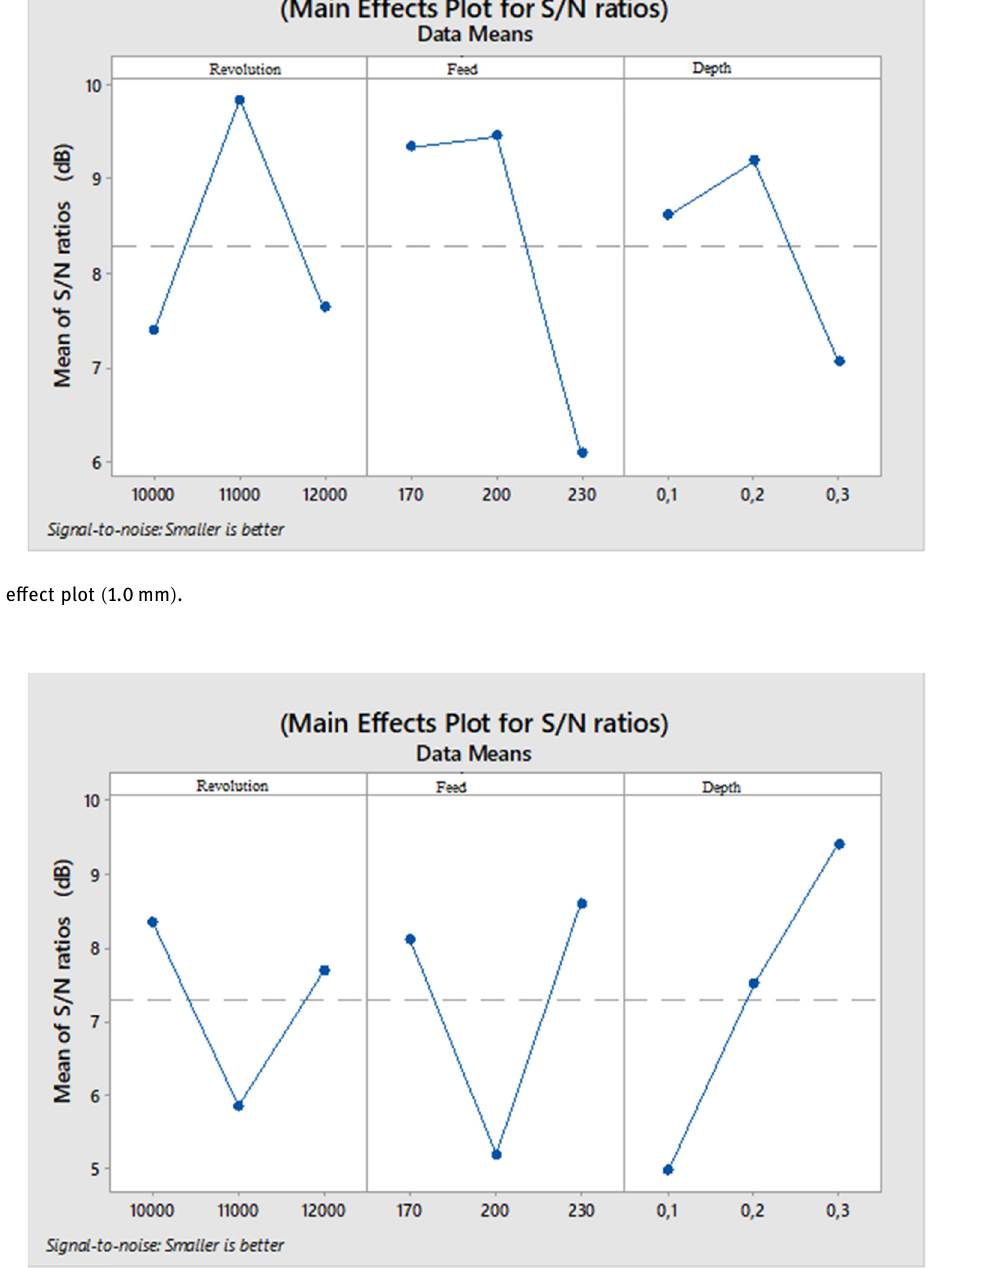
Figure 6: Main e ff ect plot ( for 0.8 mm tool )